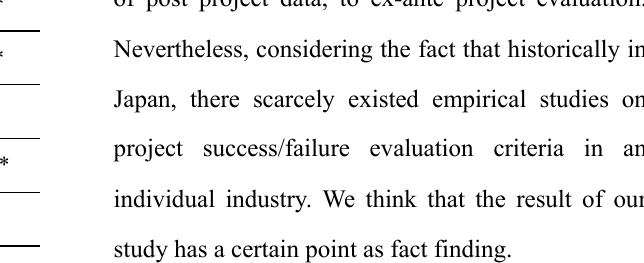
Table 3. Result of Discriminant Analysis discriminant